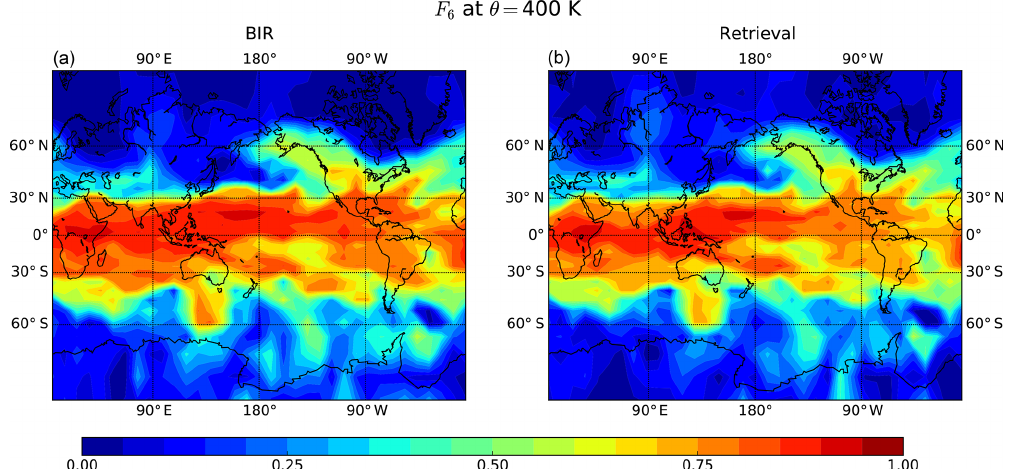
Figure 7. Young ( τ < 6 months) air mass fraction F 6 at θ = 400K on 31 December 1983, as estimated from the BIR method (a) and the retrieval (b) .